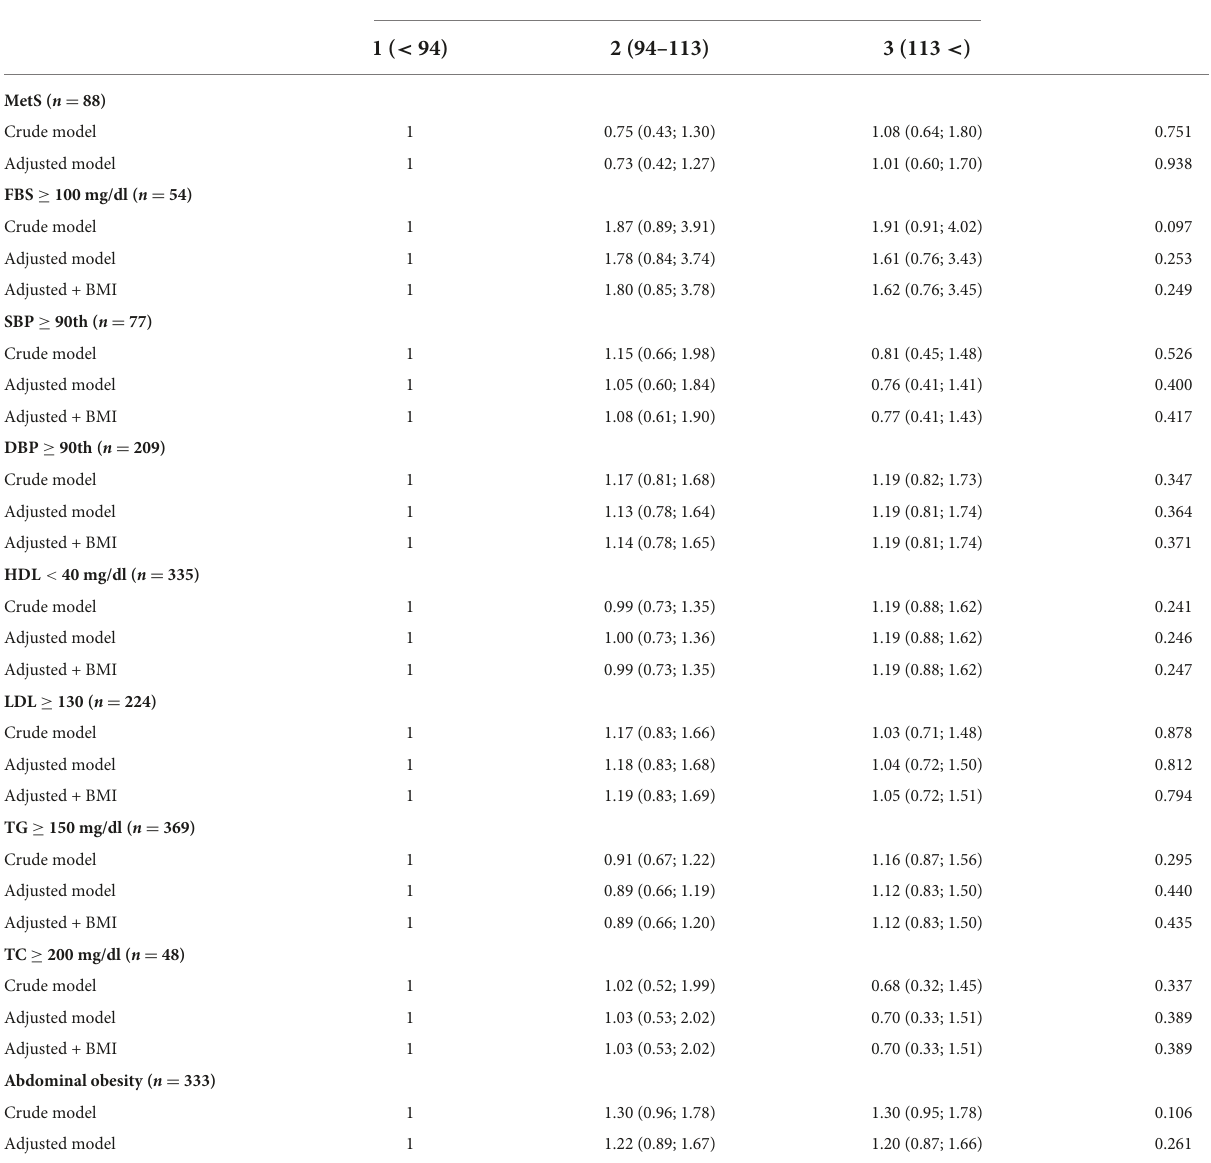
TABLE 3 Association between metabolic syndrome components and dyslipidemia with tertiles of serum zinc in children: logistic regression analysis.